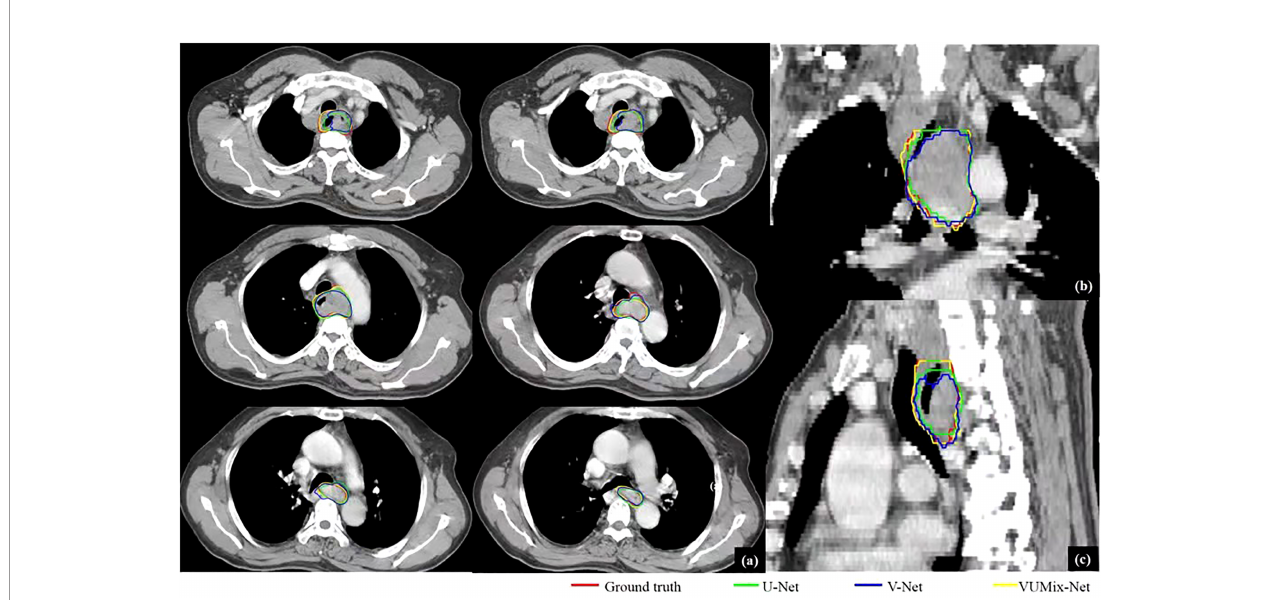
FIGURE 4 | GTV delineations for a patient predicted from U-Net, V-Net, and VUMix-Net. (A) GTV on six transversal planes, (B) GTV on a coronal plane, (C) GTV on a sagittal plane. The CT slices were scanned from an upper esophageal cancer